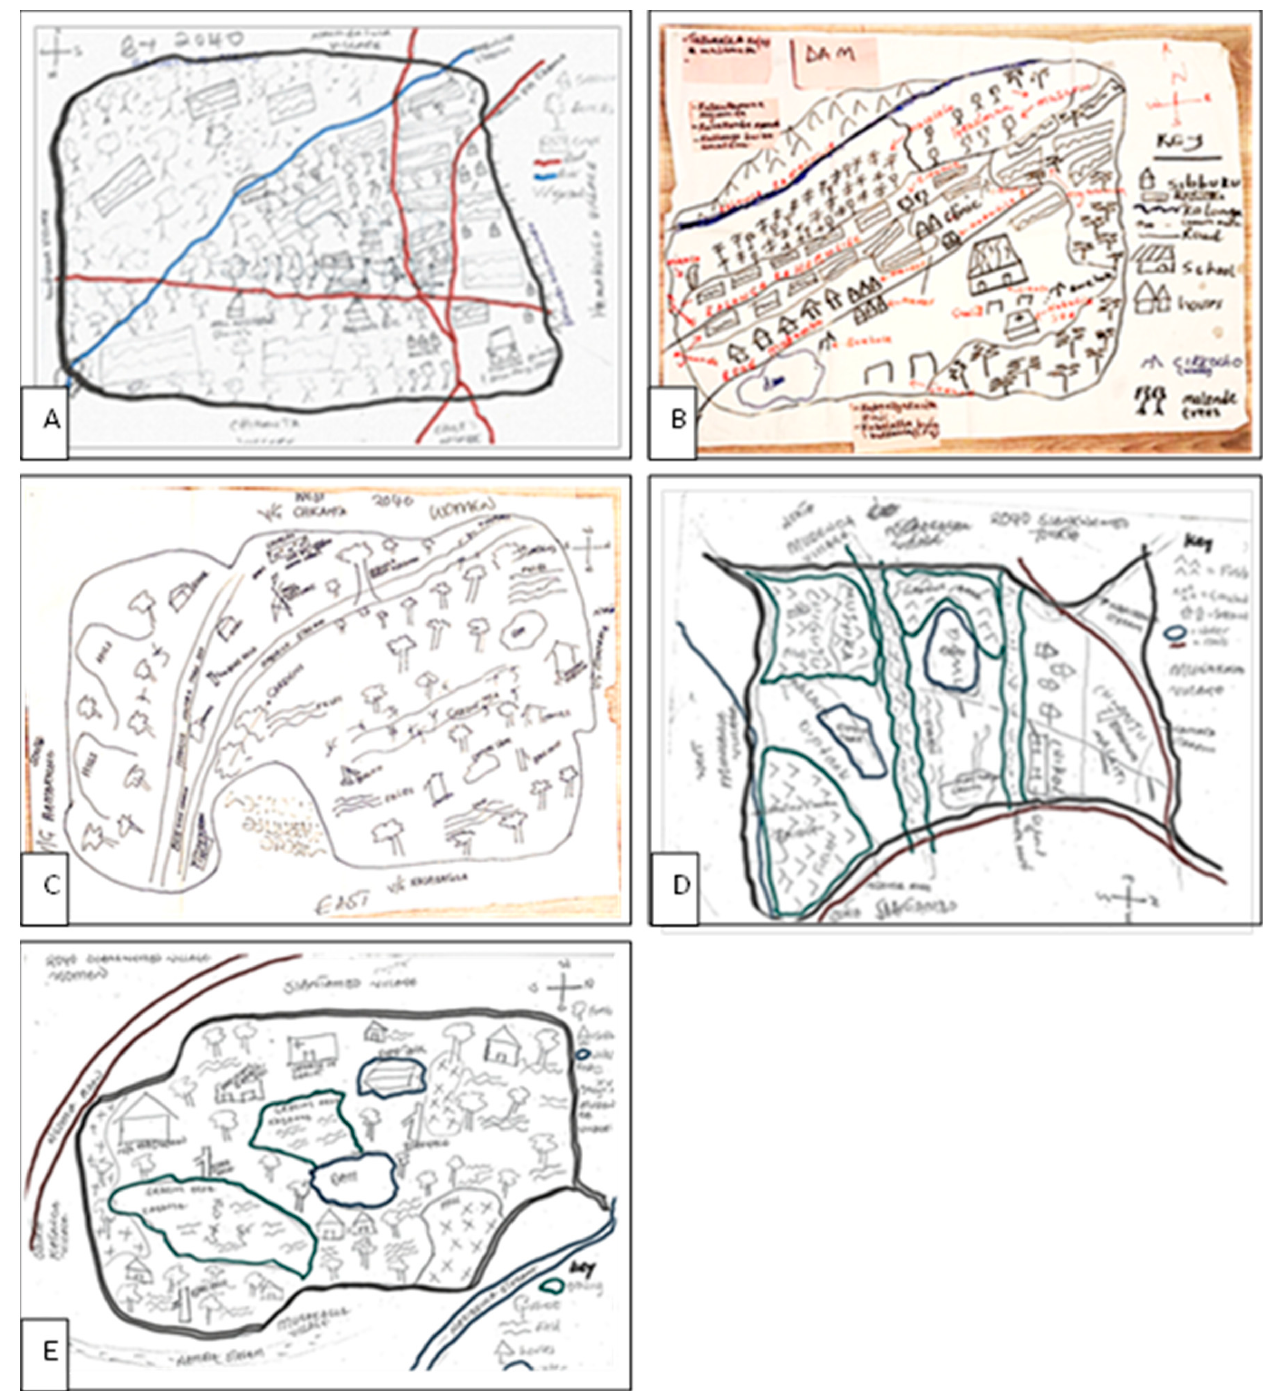
Figure 4. Participatory maps drawn in the two MSP workshops. MSP1—( A ) male group, ( B ) youth group, ( C ) female group. MSP2—( D ) female group, ( E ) youth group.